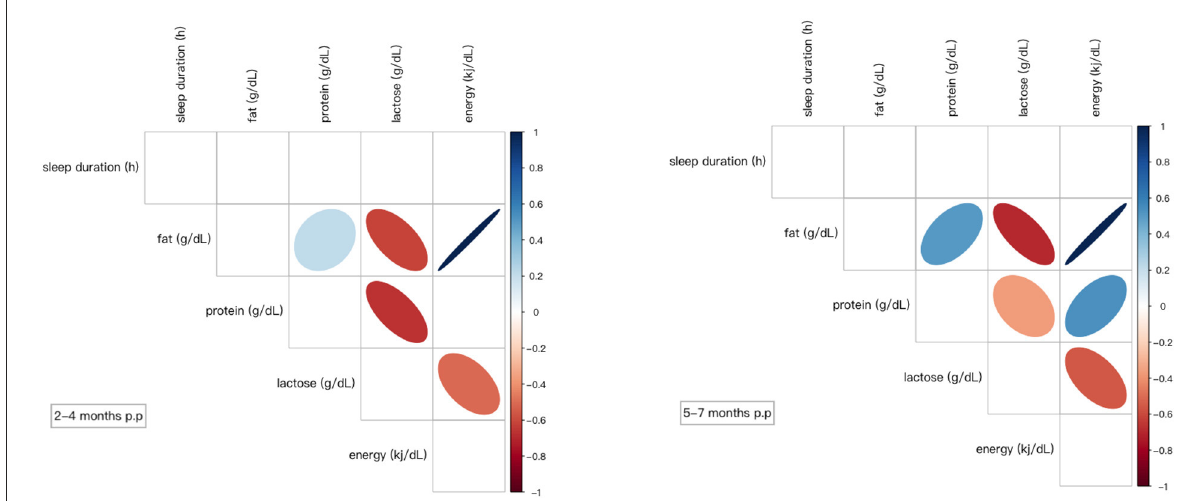
which concluded that exclusive breastfeeding is associated with reduced maternal sleep duration (average 7.08 h daily)